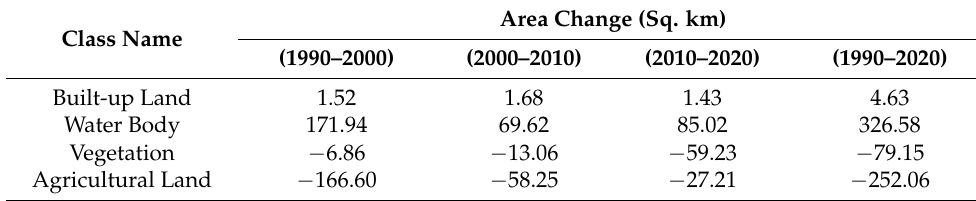
Table 4. Loss and gain analysis of the LU/LC